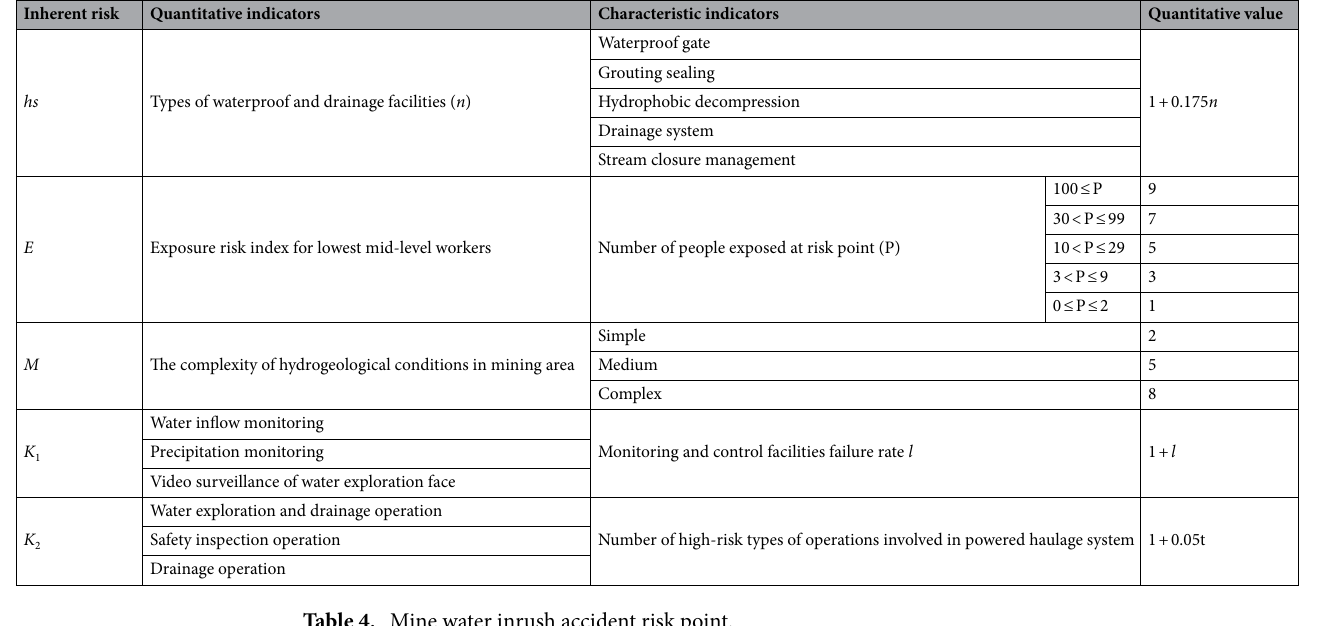
Table 4. Mine water inrush accident risk